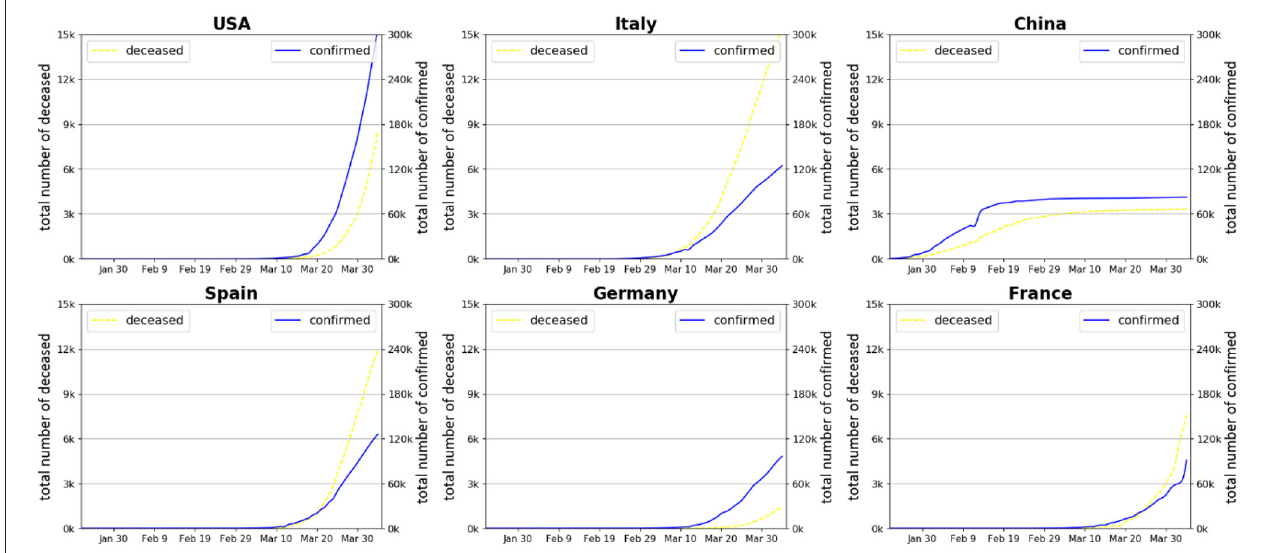
FIGURE 1 | Number of confirmed cases and deceased patients in six countries during the early stage of COVID-19 pandemic development. Source: World Health Organization (